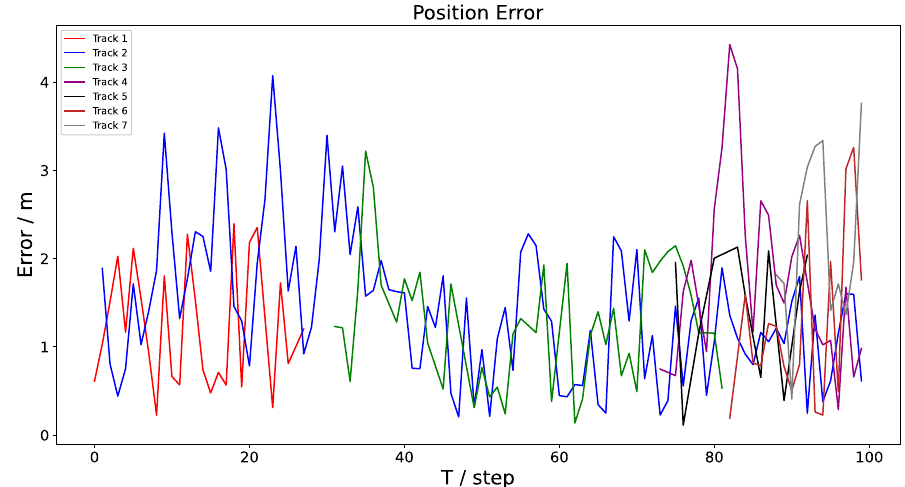
Figure 27. Tracking error between the prediction and actual track (REMTT).